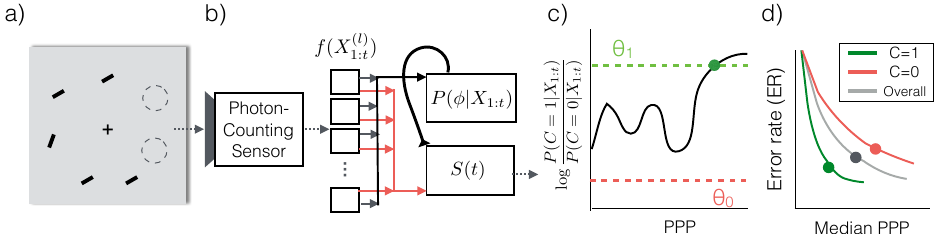
Figure 5. low-light Search. ( a ) Search stimuli with L = 7 display locations and 5 objects (oriented bars). The dashed circles are not part of the display but used to indicate empty locations. ( b ) The search ) go through two circuits, one estimates the scene properties algorithm. Local classification results f ( X ( l ) 1: t P ( φ X 1: t ) (Equation (7)) and sends feedback to the other circuit that computes the log likelihood ratio | S ( t ) (Equation (5)). ( c ) SPRT compares S ( t ) against a pair of thresholds θ 1 and θ 0 to decide whether to declare target-presence or absence, or wait for more evidence (Equation (4)). ( d ) SPRT produces ER vs . PPP tradeoffs (sketch) for different conditions.